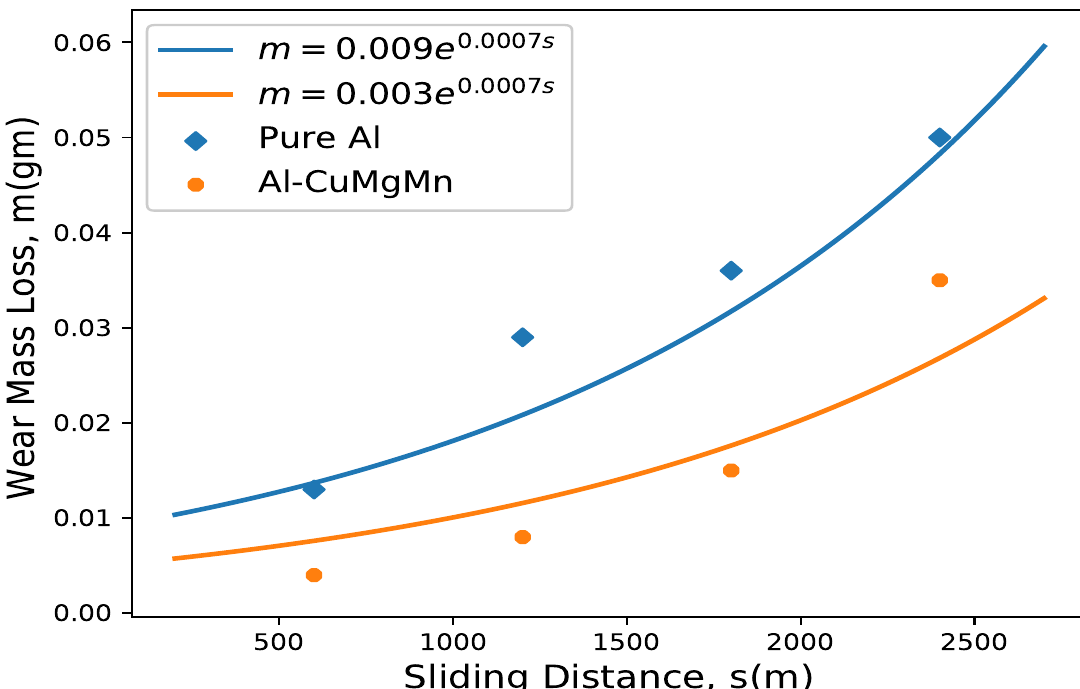
Figure 10. Effect of sliding distance and normal load on wear mass loss for samples processed by laser power 1700 W at 10 N.